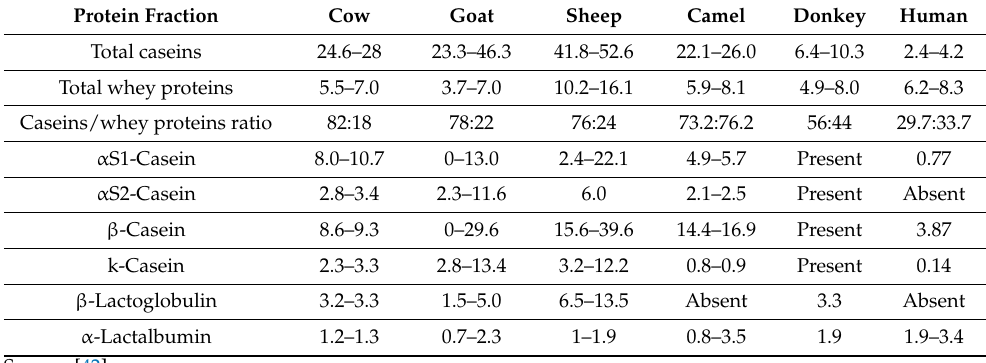
Table 2. Protein profile (g/L − 1 ) of milk from different mammalian species.